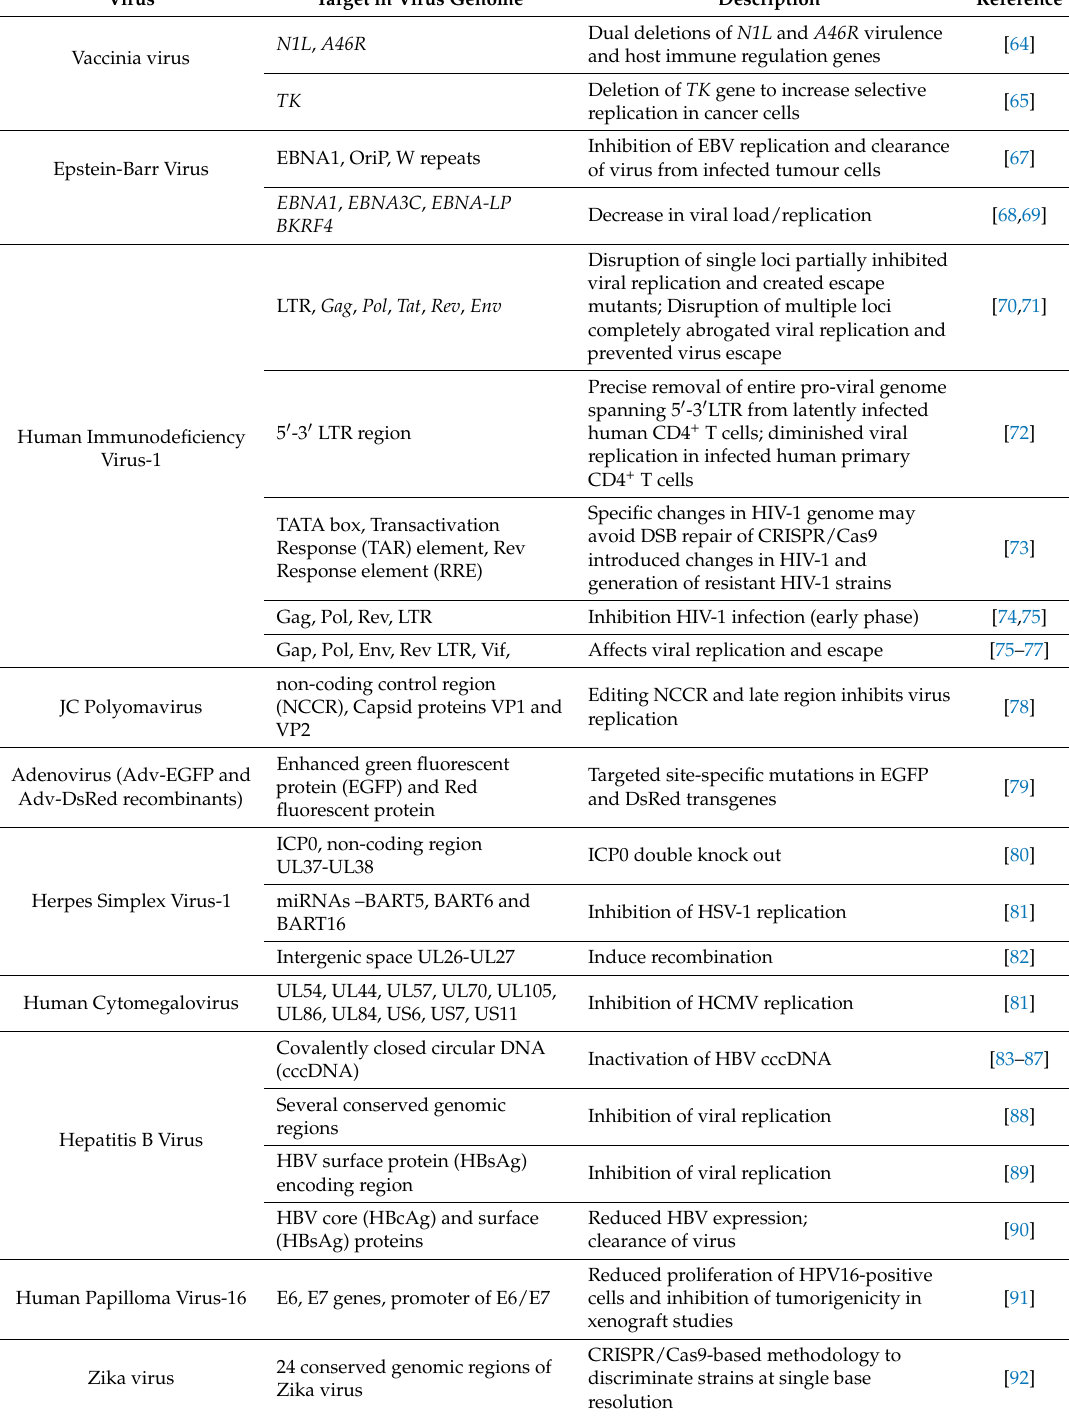
Table 1. Overview of CRISPR/Cas9 applications in genome editing of orthopoxvirus and other human viruses of clinical